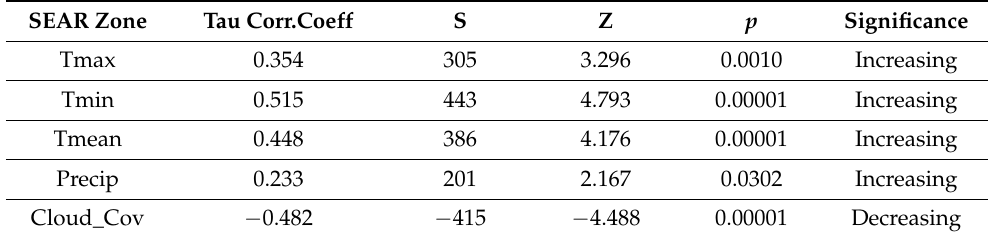
Table 6. Mann Kendall Trend Test of JJAS averaged climatic variable for SEAR zone.